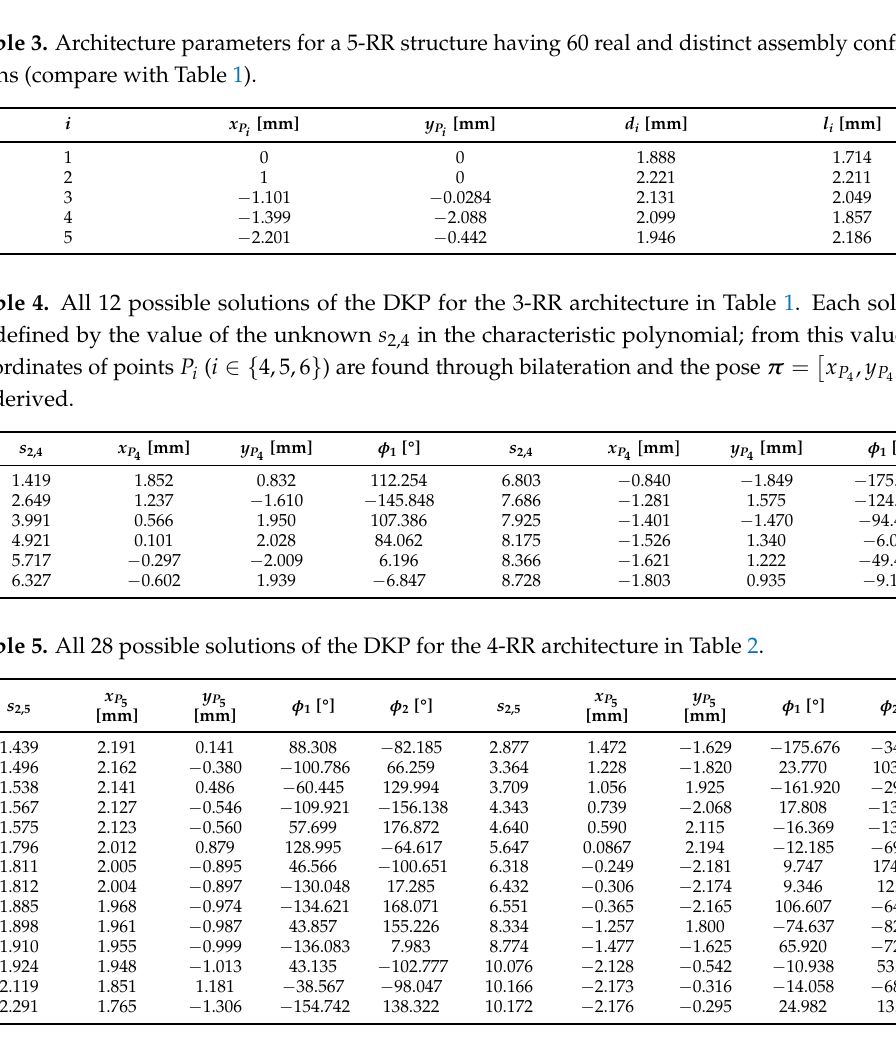
Table 3. Architecture parameters for a 5-RR structure having 60 real and distinct assembly configura- tions (compare with Table 1).